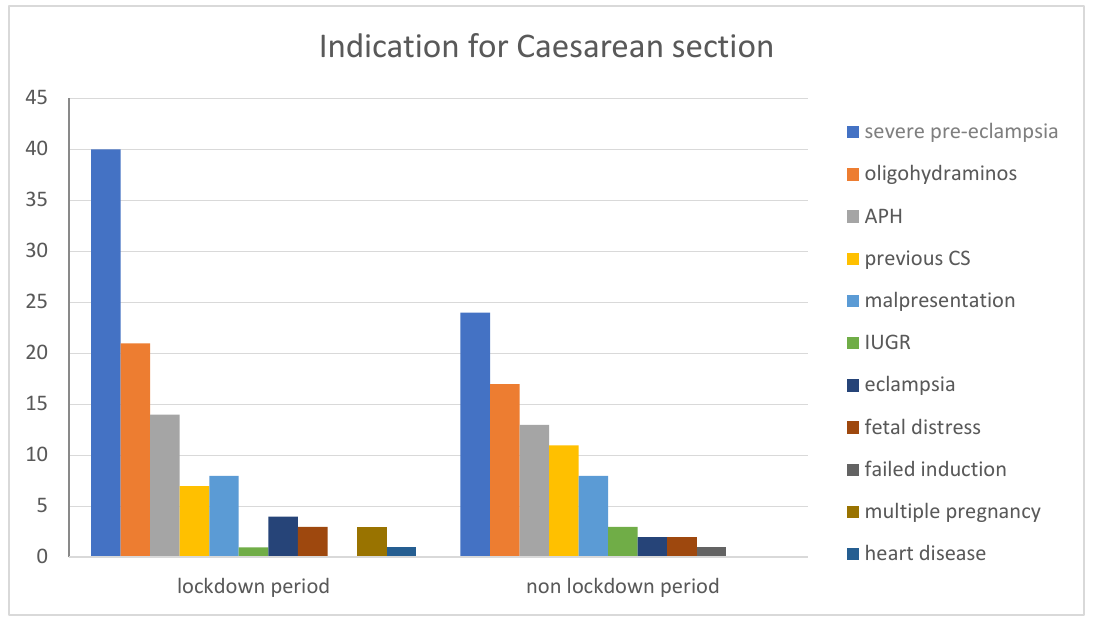
Figure 3. Indications for caesarean section during the lockdown and the non-lockdown